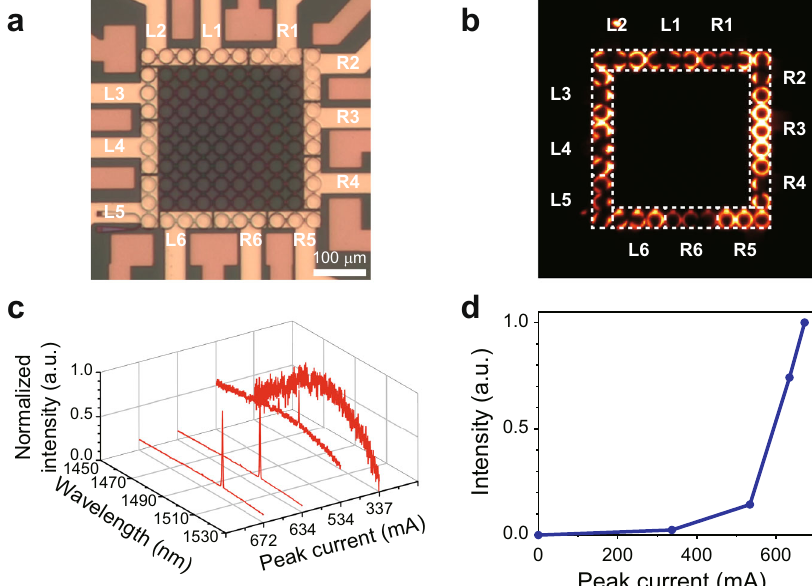
Fig. 3 Electroluminescence measurements of the topological insulator laser. a The microscope image of the fabricated topological insulator laser array (top view). In order to selectively excite the topological edge mode, electrodes are designed only at the perimeter of the array (dark orange: cathode, bright orange: anode). R and L labels indicate that the position of the metal pad connected to the electrode is on the right and left, respectively. The scale bar is 100 μ m. b Intensity pro fi le image of topological insulator laser array when all peripheral sites are pumped at the same level. c Spectral evolution of the laser emission as a function of the peak pump current. d Measured light-current curve of the laser. The resolution of the spectrometer is 0.2